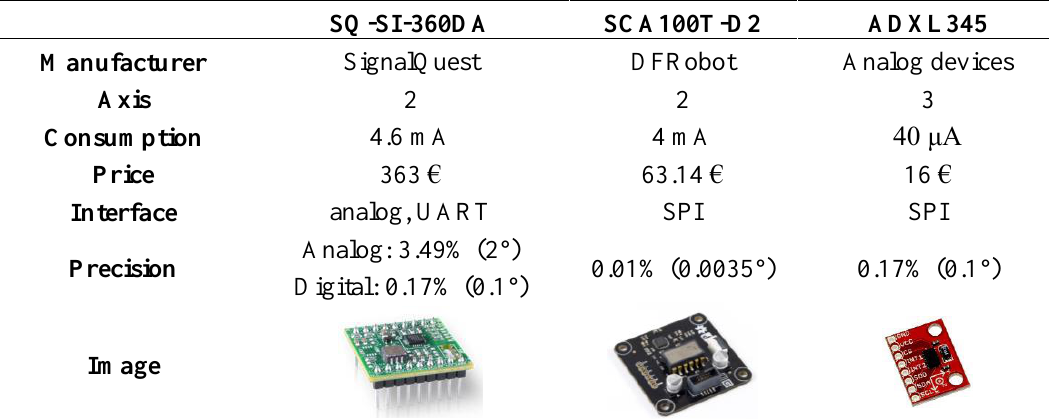
Table 3. Technical characteristics of the evaluated